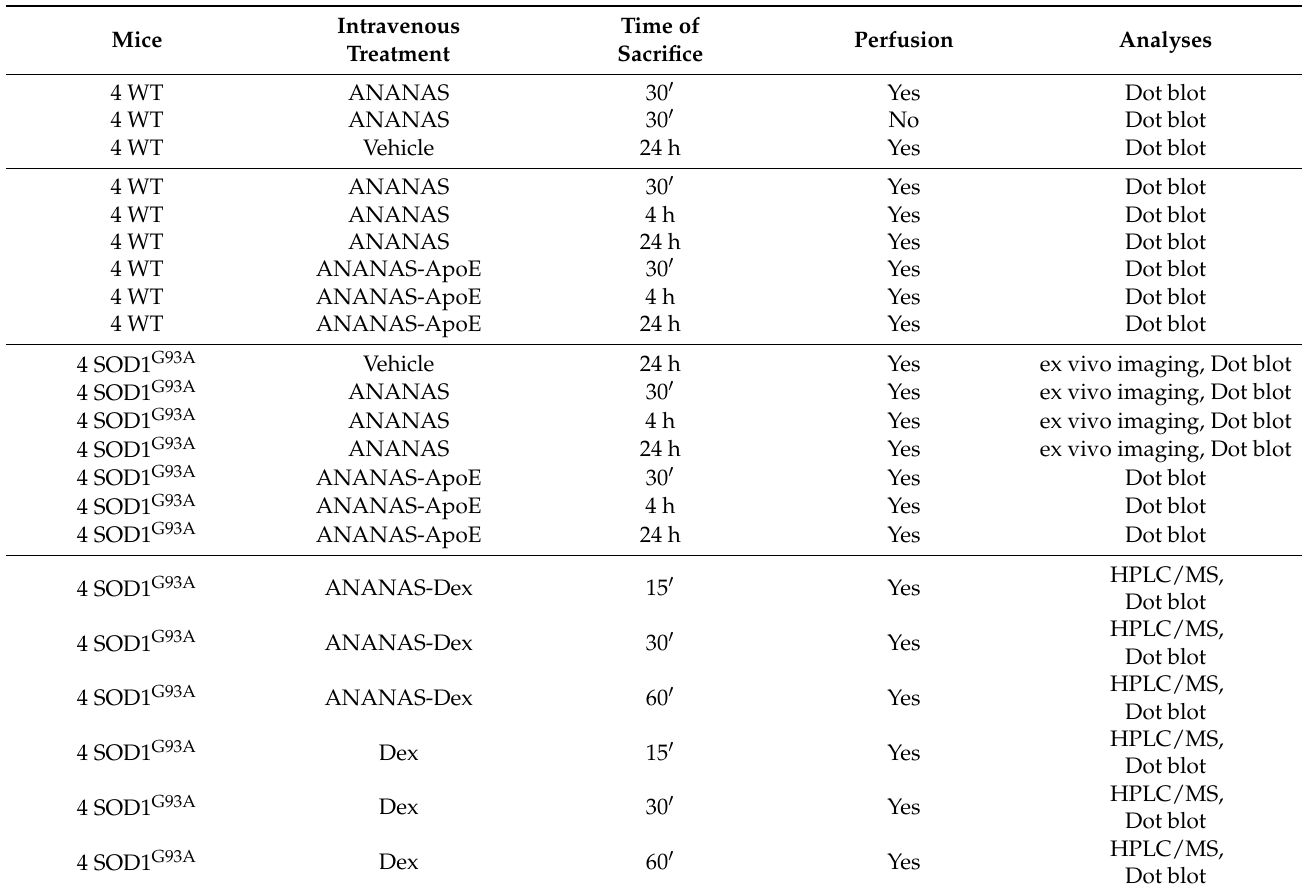
Table 1. Animals, treatment schemes, and type of